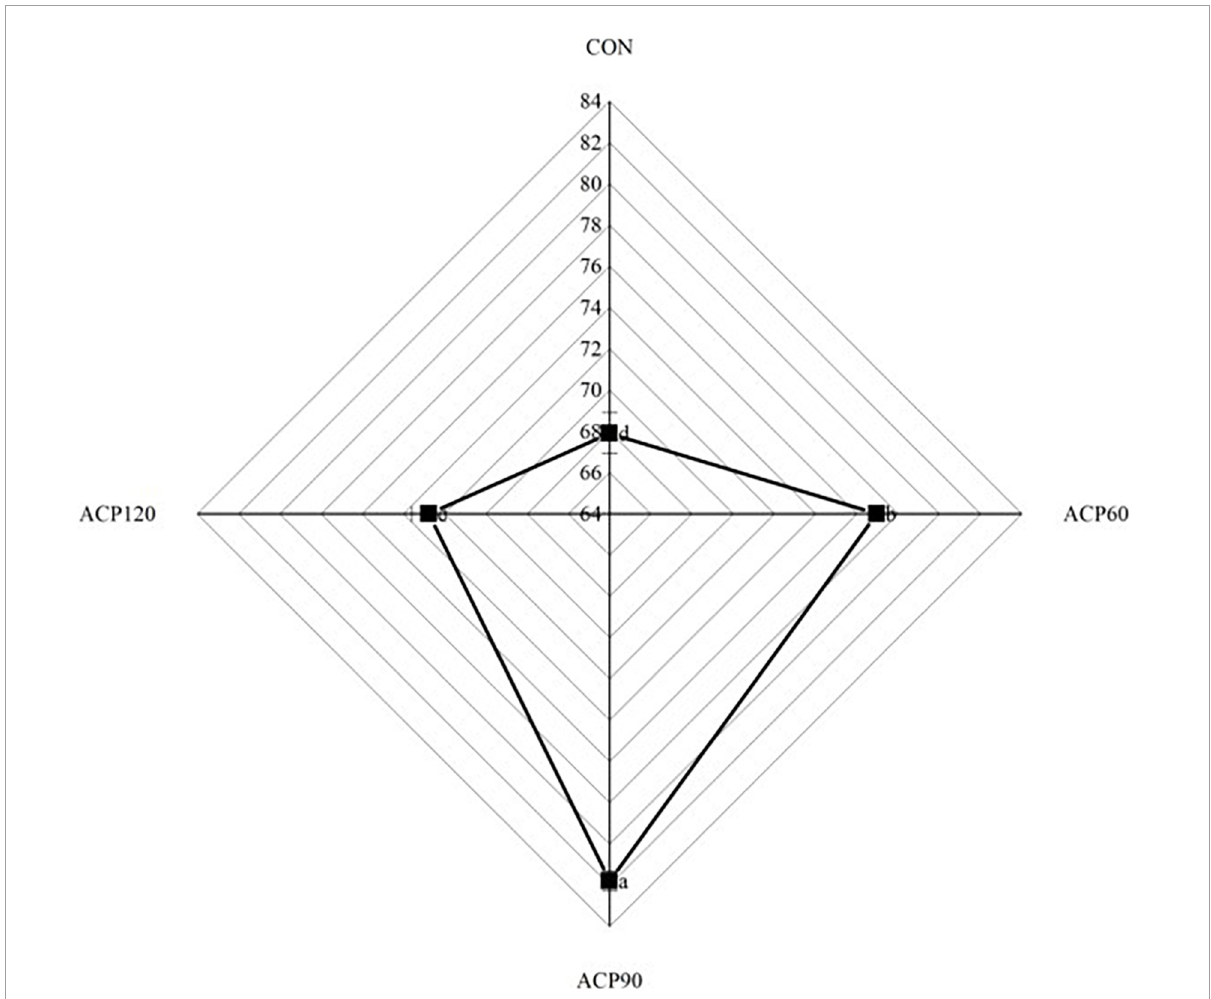
FIGURE3 Whiteness of surimi gels without and with ACP treatment. The different lowercase letters represent significant differences ( p < 0.05). (CON, surimi gels without ACP treatment; ACP60, surimi gels treated with ACP for 60 s; ACP90, surimi gels treated with ACP for 90 s; ACP120, surimi gels treated with ACP for 120